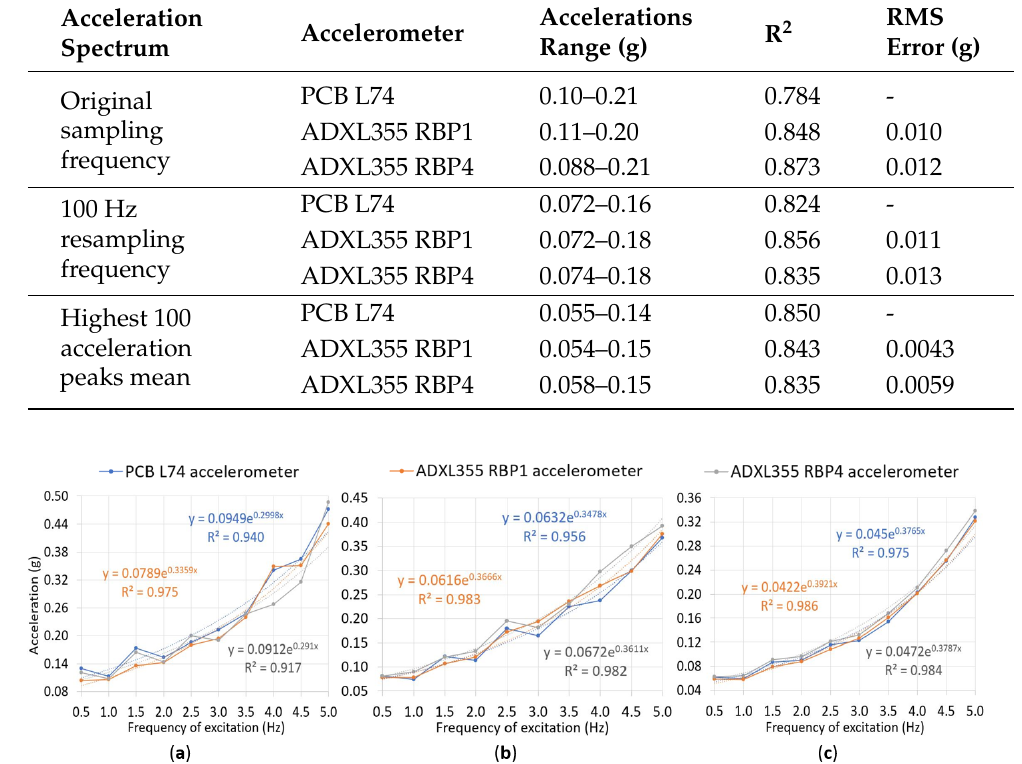
Figure 12. Acceleration spectra for the 0.25 cm displacement frequency chirp: ( a ) Maximum accelera- tion spectrum from original sampling frequency. ( b ) Maximum acceleration spectrum from 100 Hz resampling frequency. ( c ) Acceleration spectrum from the mean of the highest 100 acceleration peaks from 100 Hz resampling